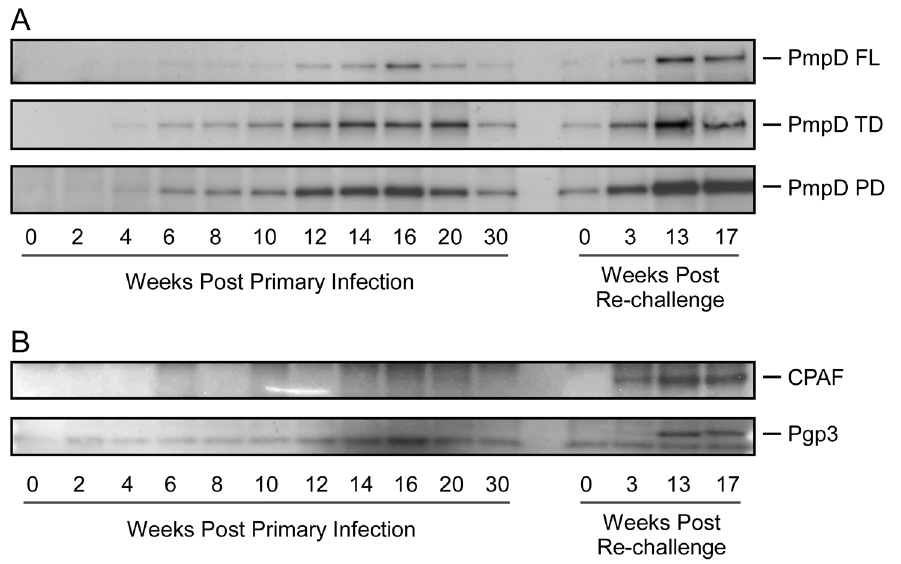
Figure 3. Identification of trachoma conserved antigens by western blotting using chlamydial antigen specific antibodies. IP was performed using monkey RML134 serum and chlamydial proteins prepared from non-denaturing detergent lysed non-radiolabeled A2497 infected McCoy cells. The IP proteins we identified by Western blot using a panel of rabbit monospecific antibodies generated against PmpD and mouse monoclonal antibodies specific to CPAF and Pgp3. (A) The higher MW polypeptides were identified as full length PmpD (155 kDa) and its proteolytically processed 82 kDa translocator and 73 kDa passenger domains [10] (B) Two lower MW polypeptides reacted with antibodies specific to CPAF and Pgp3.